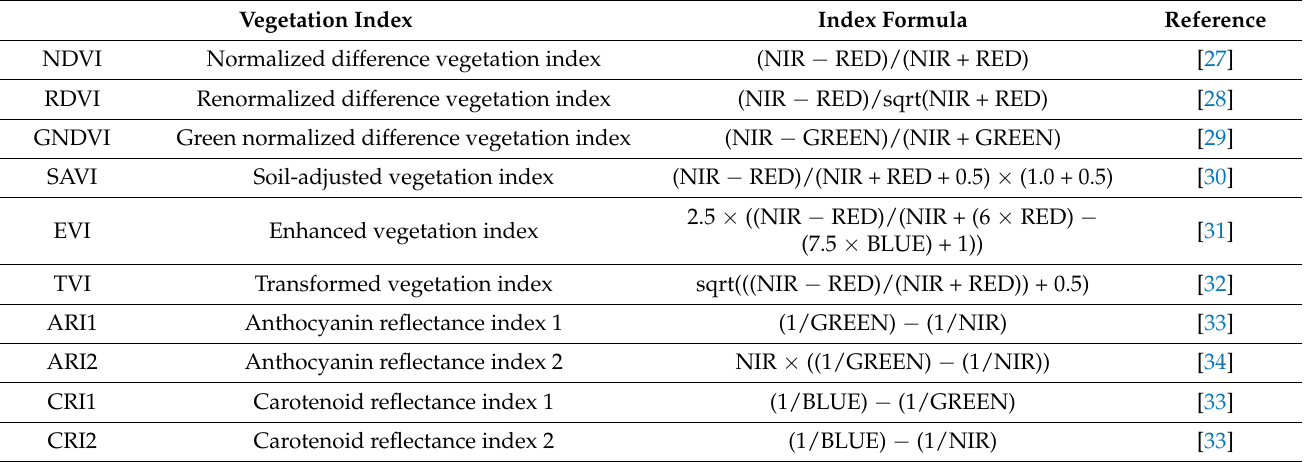
Table 1. List of created vegetation indices calculated and used as training